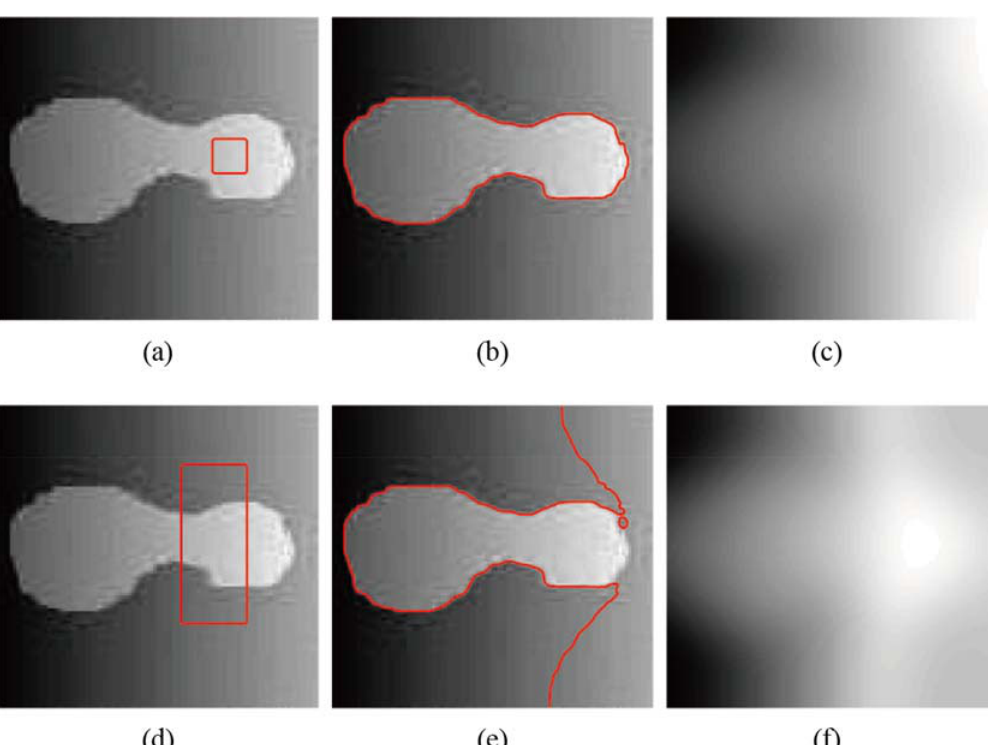
Fig 3. Segmentation of Li ’ s model. (a), (d) The original image with red initial contours. (b), (e) The final segmentation results of Li ’ s model. (c), (f) The bias field estimation of Li ’ s model.